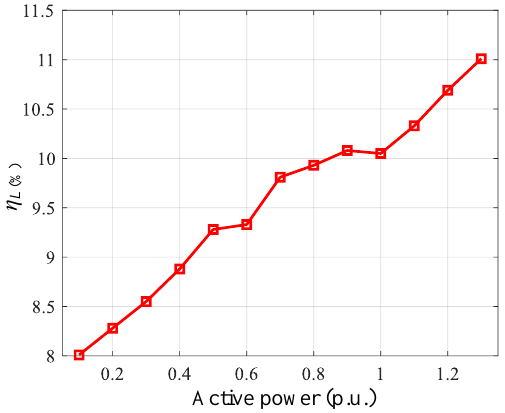
Figure 6. Values of η L with different power levels.